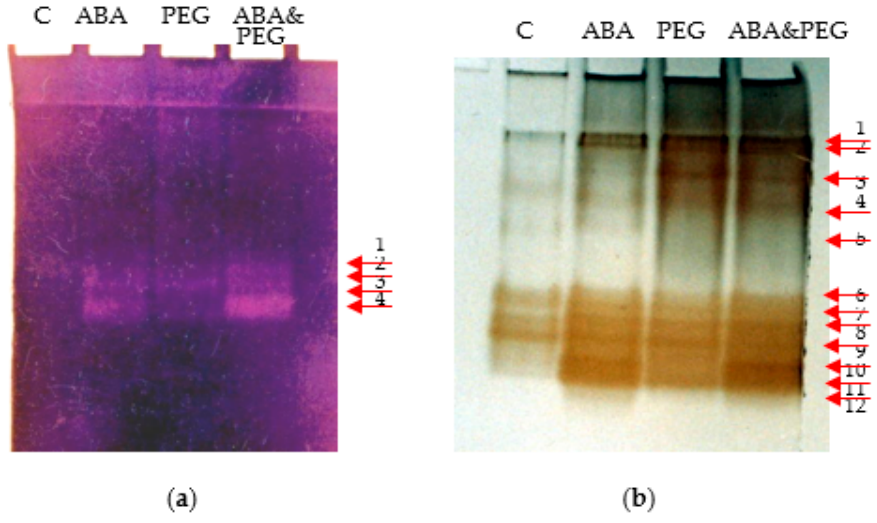
Figure 3. SODs ( a ) and POXs ( b ) isoforms revealed into electrophoretic gels of tobacco hypocotyls ( N. tabacum L., “Baladi”) that have been submitted to the effect of ABA, PEG and ABA & PEG. In the right there are red arrows to emphasize the expression of isoforms after electrophoresis. C: control.